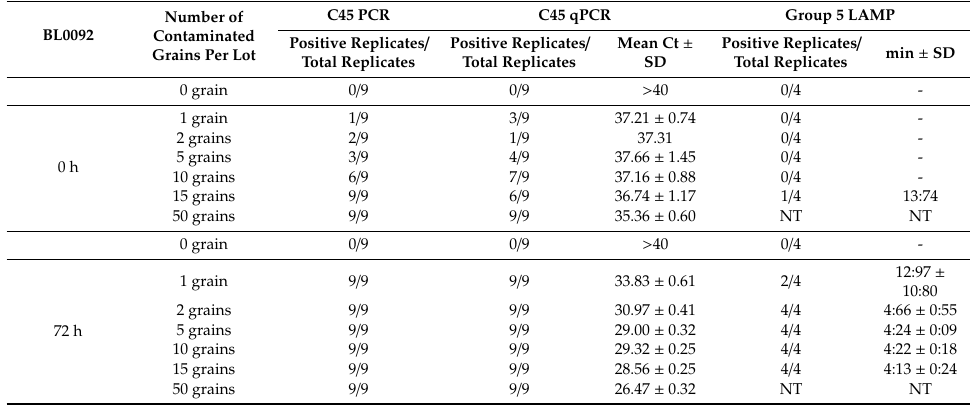
Table 2. Sensitivity of the PCR (C45 primers), qPCR (C45 primers), and LAMP (group 5 primers) tests in seed matrix contaminated with a Triticum lineage P. oryzae strain